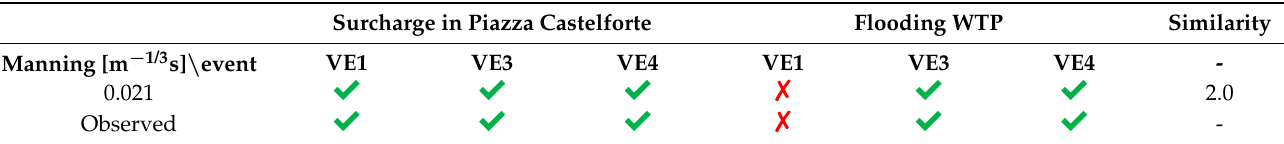
Table 2. Calibration similarity matrix.